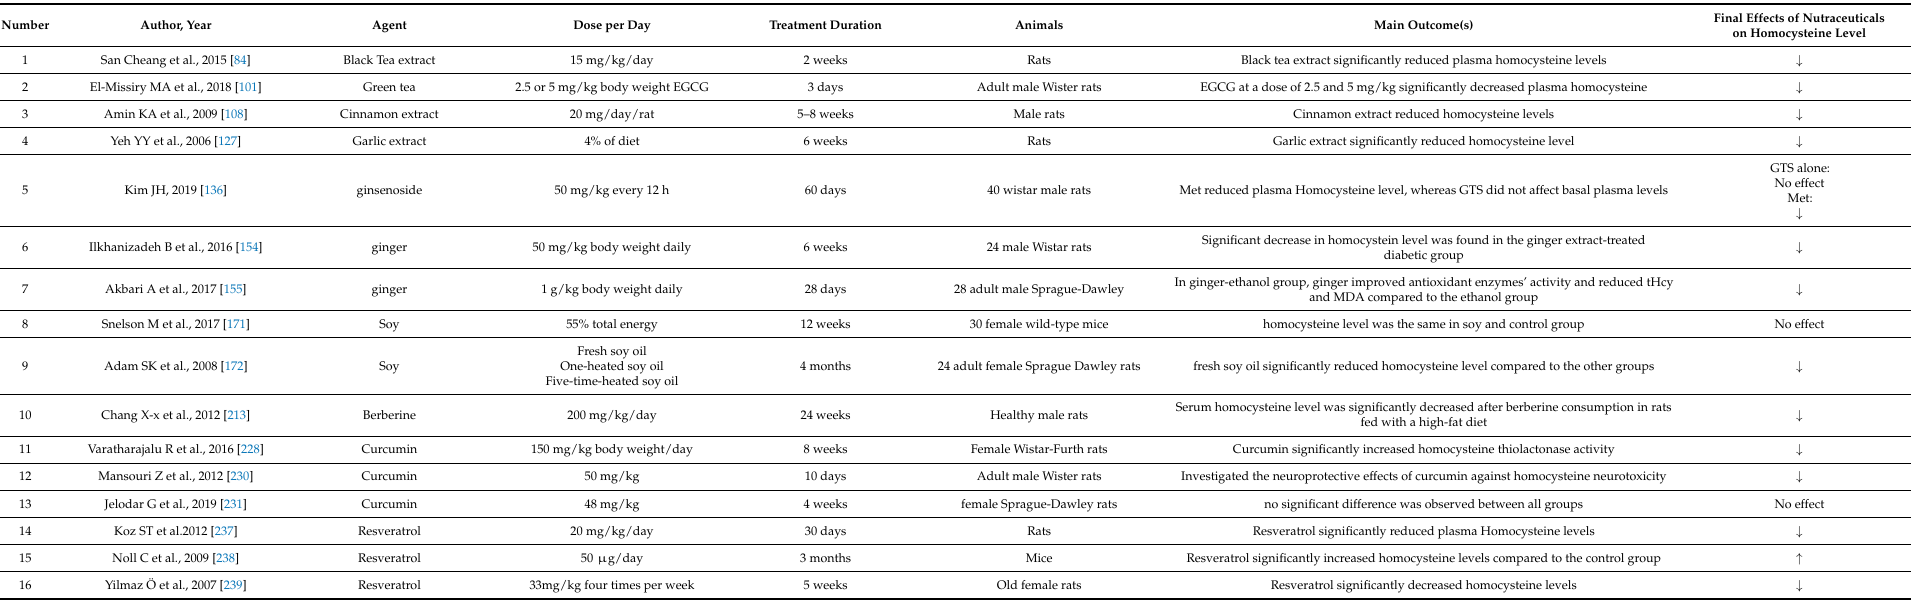
Table 2. The effect of herbal bioactive compounds on homocysteine levels based on animal